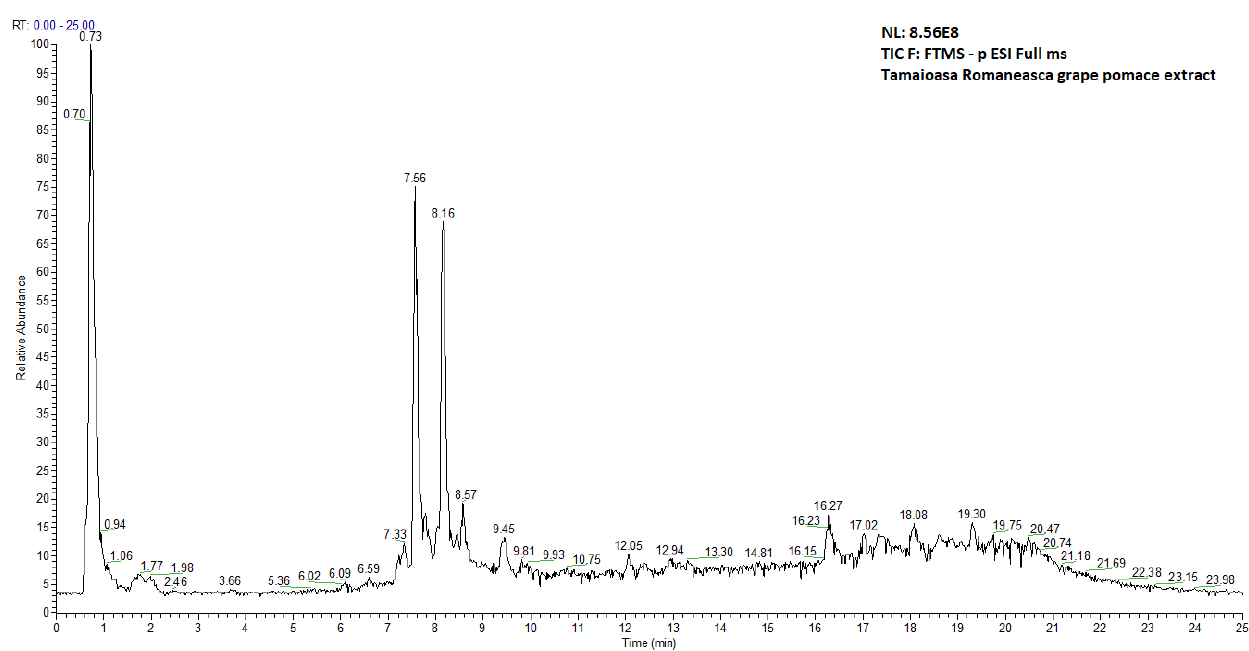
Figure 3. The obtained total ion current (TIC) chromatogram for the separation of polyphenolic compounds from Feteasca Neagra grape pomace extract by UHPLC–MS/MS detection in negative ionization mode. Table 1. The identification of phenolic compounds in grape pomace by UHPLC-HRMS with structures confirmed by comparison with reference